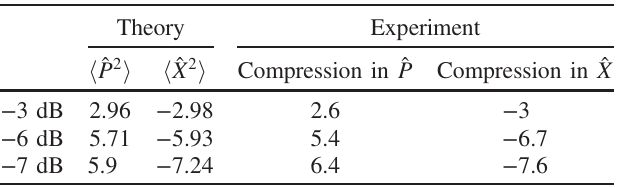
TABLE IV. Summary of achieved compression on